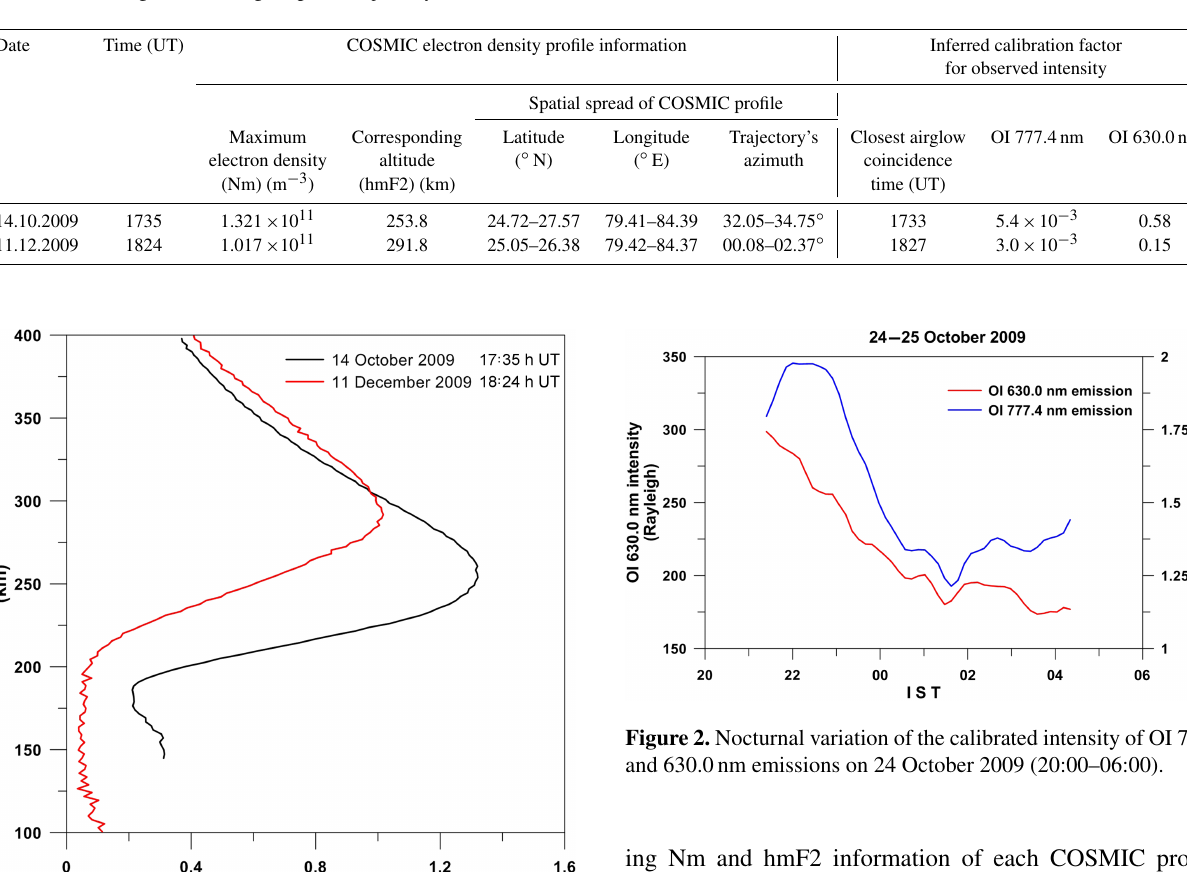
Table 1. Calibration factor of OI 777.4 and 630.0nm emission intensity inferred using the coincidental COSMIC profiles along with the azimuthal smearing of their tangent point trajectory.